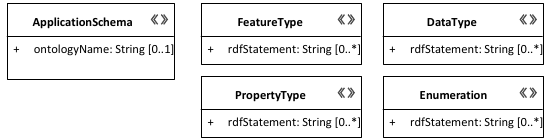
Figure 8. Extension of stereotypes in the OWL Encoding Profile.